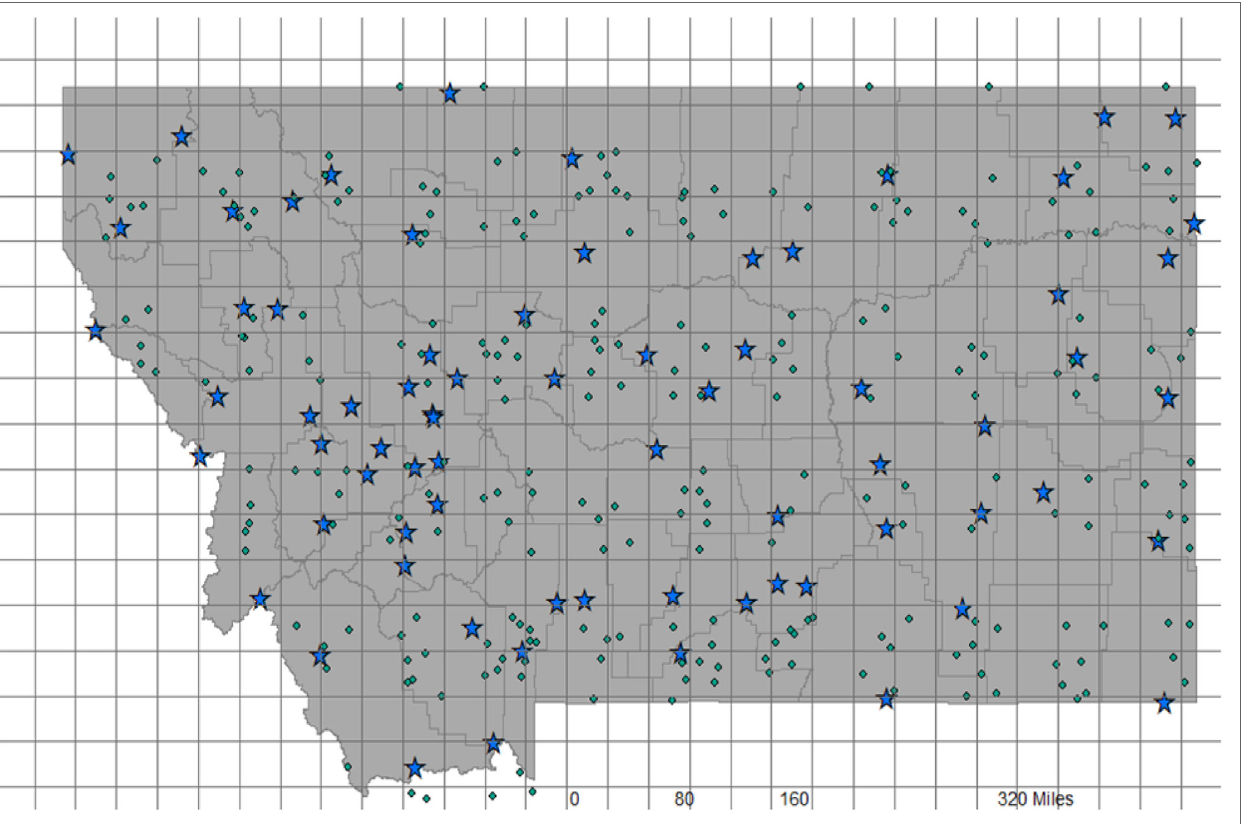
FigUre 2 | Weather stations in the state of Montana using 30 × 30 miles grid